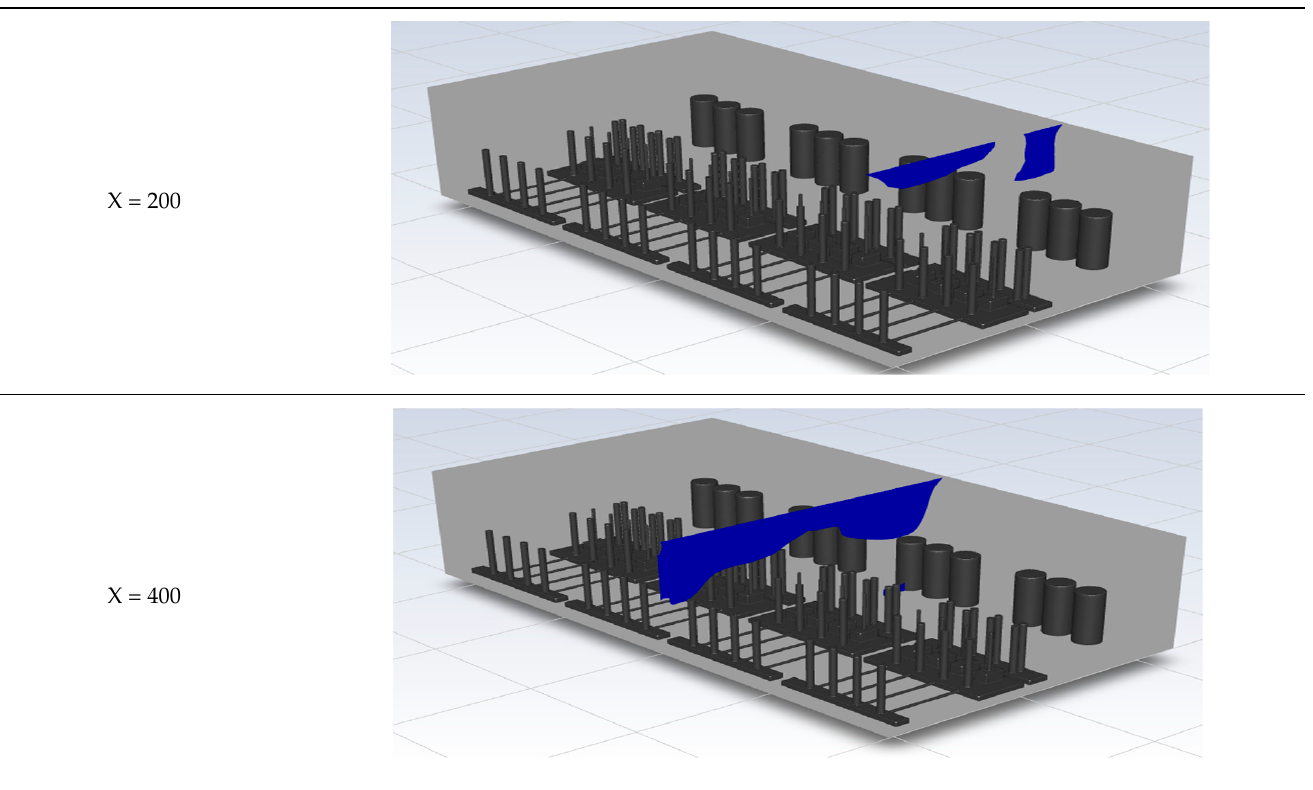
Table 8. Distribution of concentrations exceeding 25% of the LFL on the YZ section.